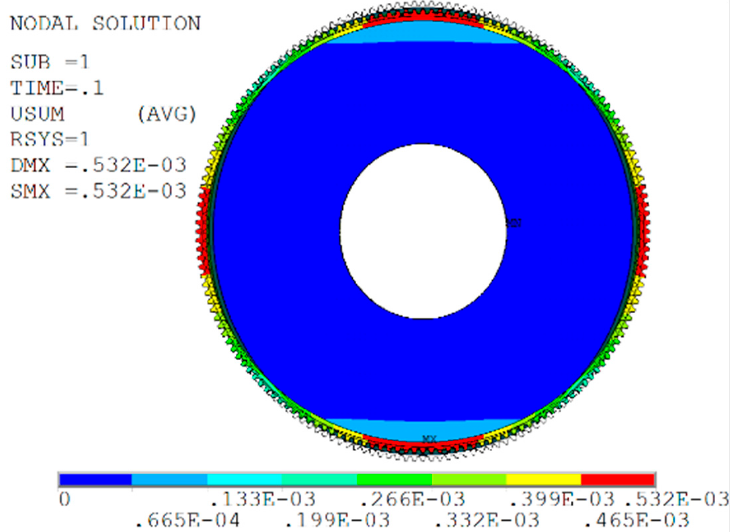
Figure 8. Displacement cloud chart of the flexible wheel.